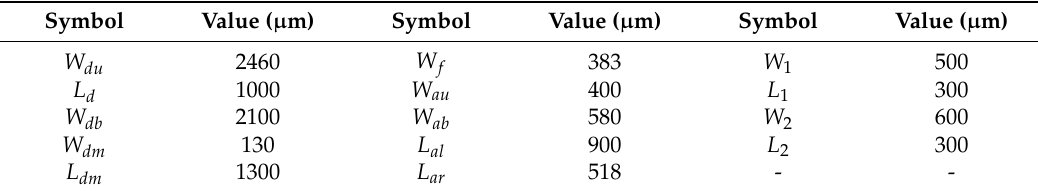
Table 1. The geometry configuration of the proposed antenna.